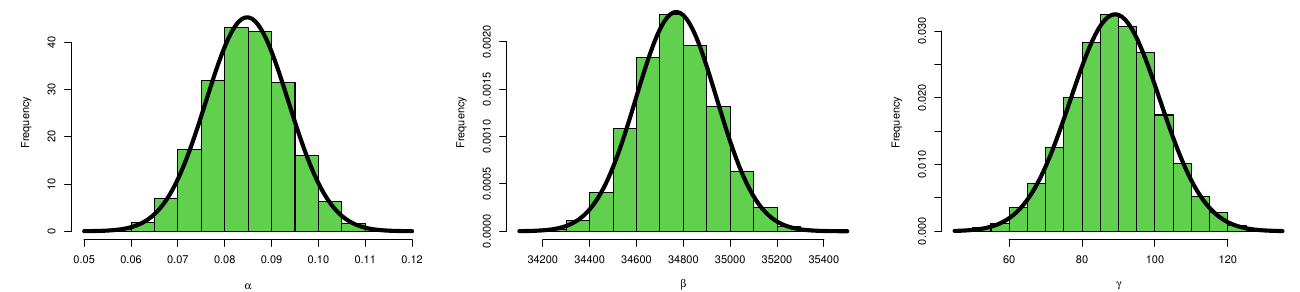
Figure 11. MCMC plot and convergence line for parameters of the KMWE model for food chain data.